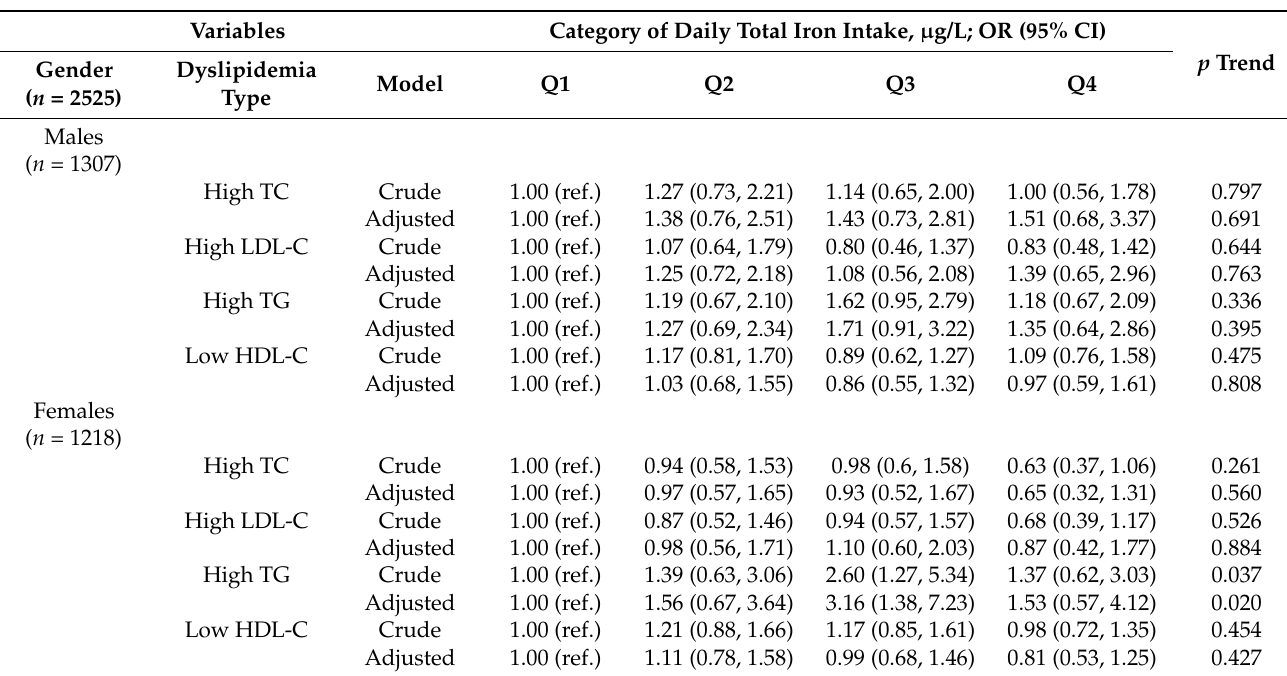
Table 3. ORs (95% CIs) for four types of dyslipidemia according to daily total iron intake quartile categories in males and